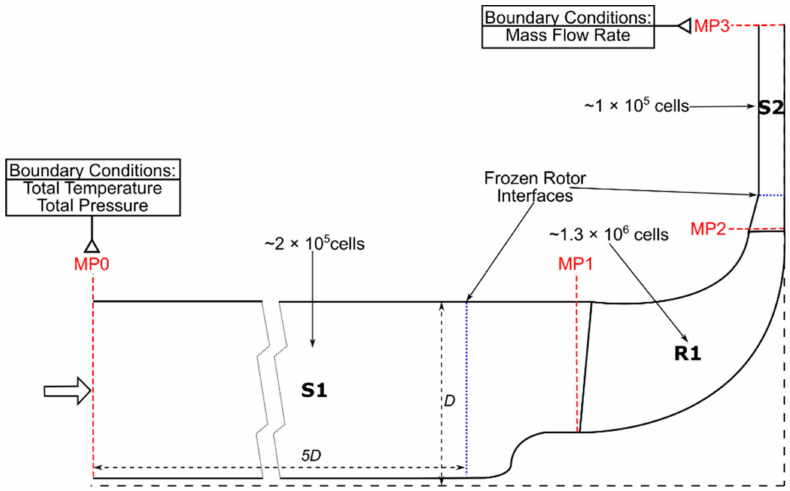
Figure 4. Baseline CFD setup. (Reproduced with permission from Taylor & Francis Group, ©2021